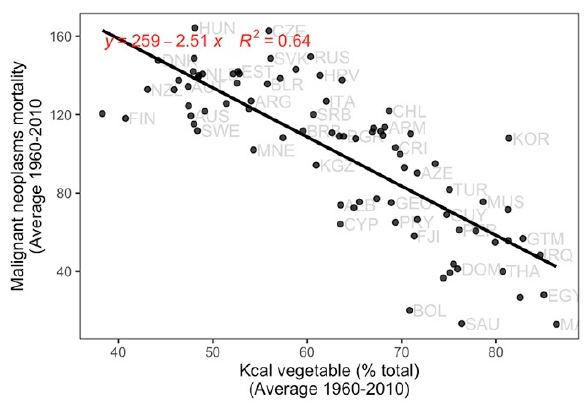
Figure 2. Relationship of the mortality (per 100,000 population) of malignant neoplasms (total number of cancers) with country annual mean percentage of total Kcal from vegetable sources. p < 0.001.